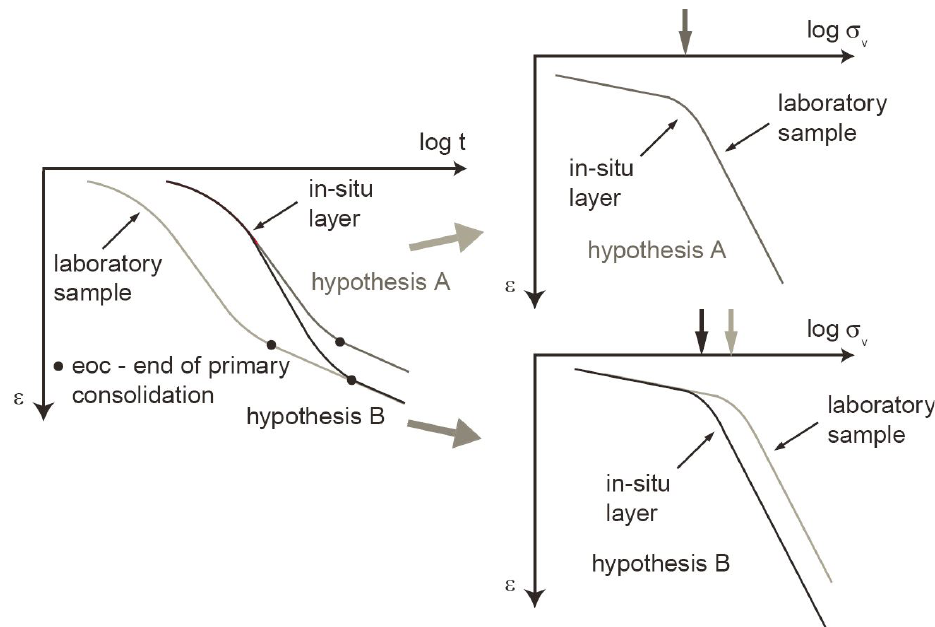
Figure 6: Creep during primary consolidation according to hypotheses A and B after Degago